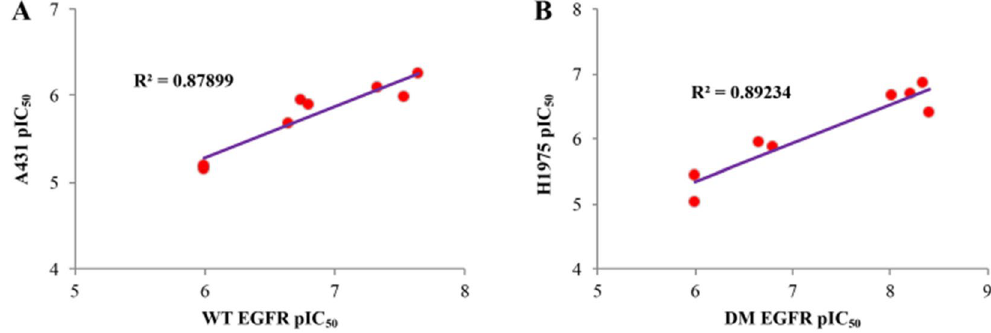
Figure 8. ( A ) Linear relationship between pIC50s against EGFR WT and pIC50s against A431 cell lines. ( B ) Linear relationship between pIC50s against EGFR DM and pIC50s against H1975 cell